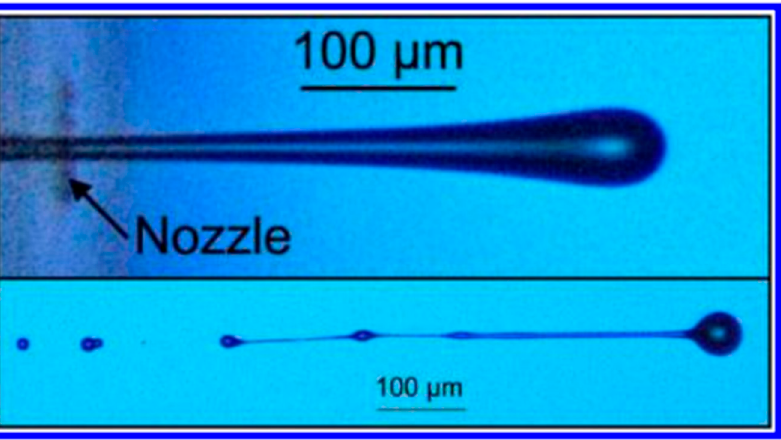
Figure 4. The upper image is a high-speed photograph of a droplet coming out of a nozzle, and the bottom one is a high-speed photograph of a satellite droplet formation [27].